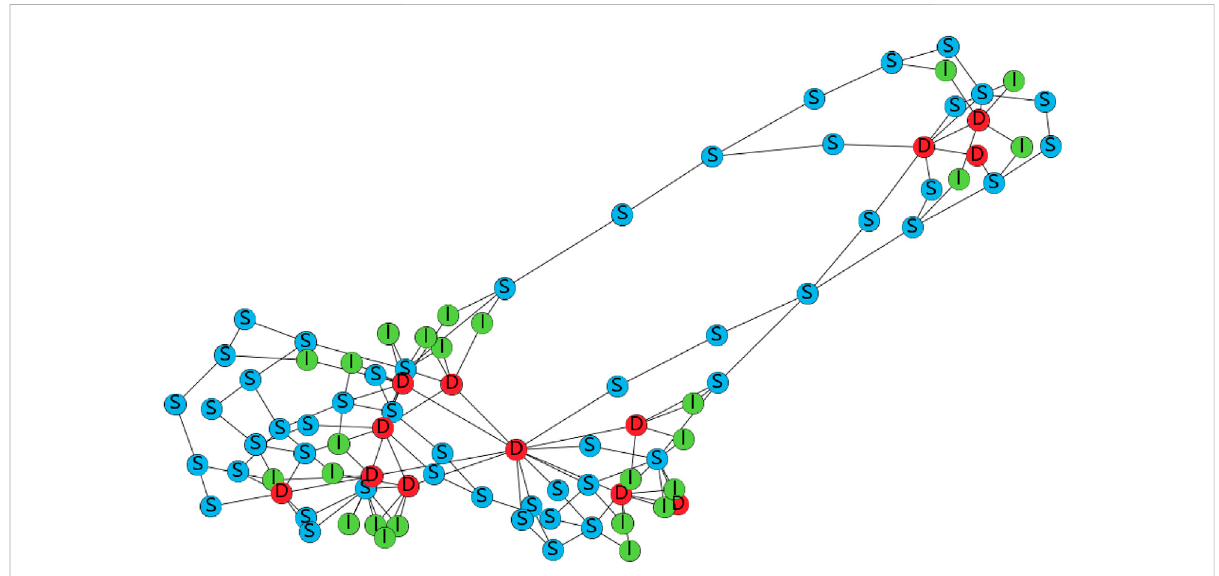
FIGURE 8 Topology diagram of the typical military network: